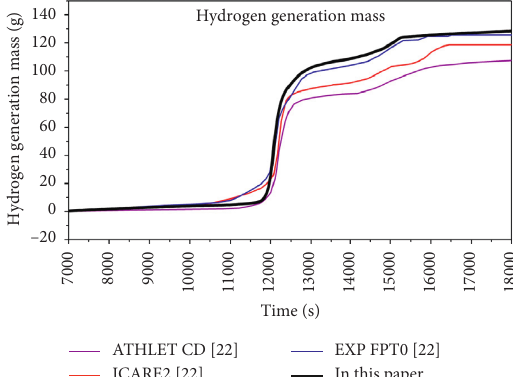
Figure 15: Cumulative hydrogen generation mass.